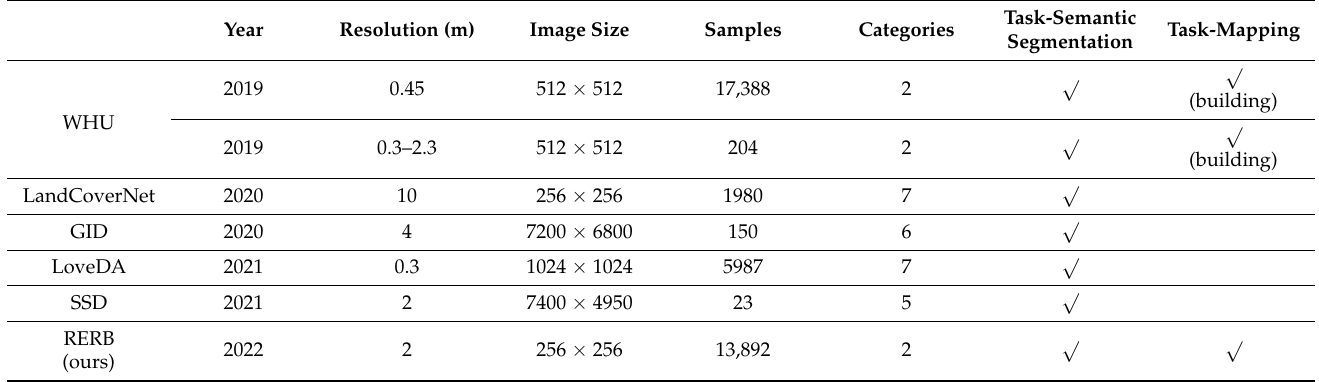
Table 1. Overall comparison of some satellite image